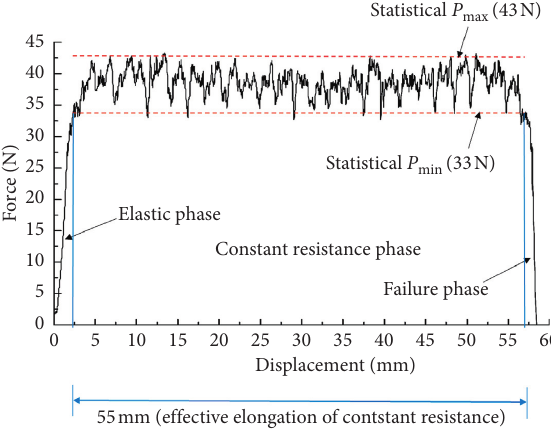
Figure 10: Model NPR bolt static tension curve.